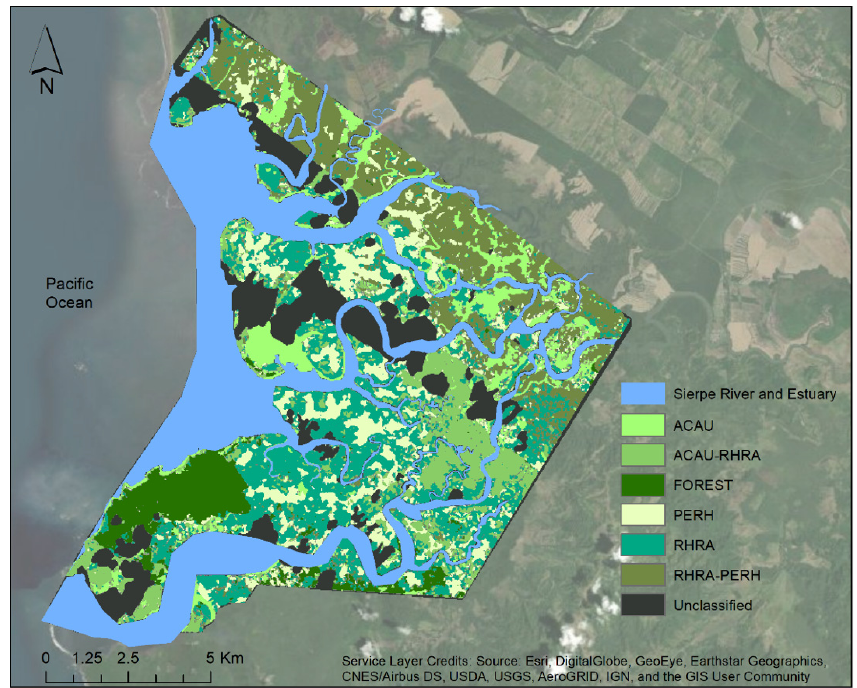
Figure 16. Species distribution map of Terraba Sierpe Mangroves produced from VNIR–ME (25 m window size) as input for a Q-SVM classifier. The unclassified areas are the pixels with clouds and cloud shadows.